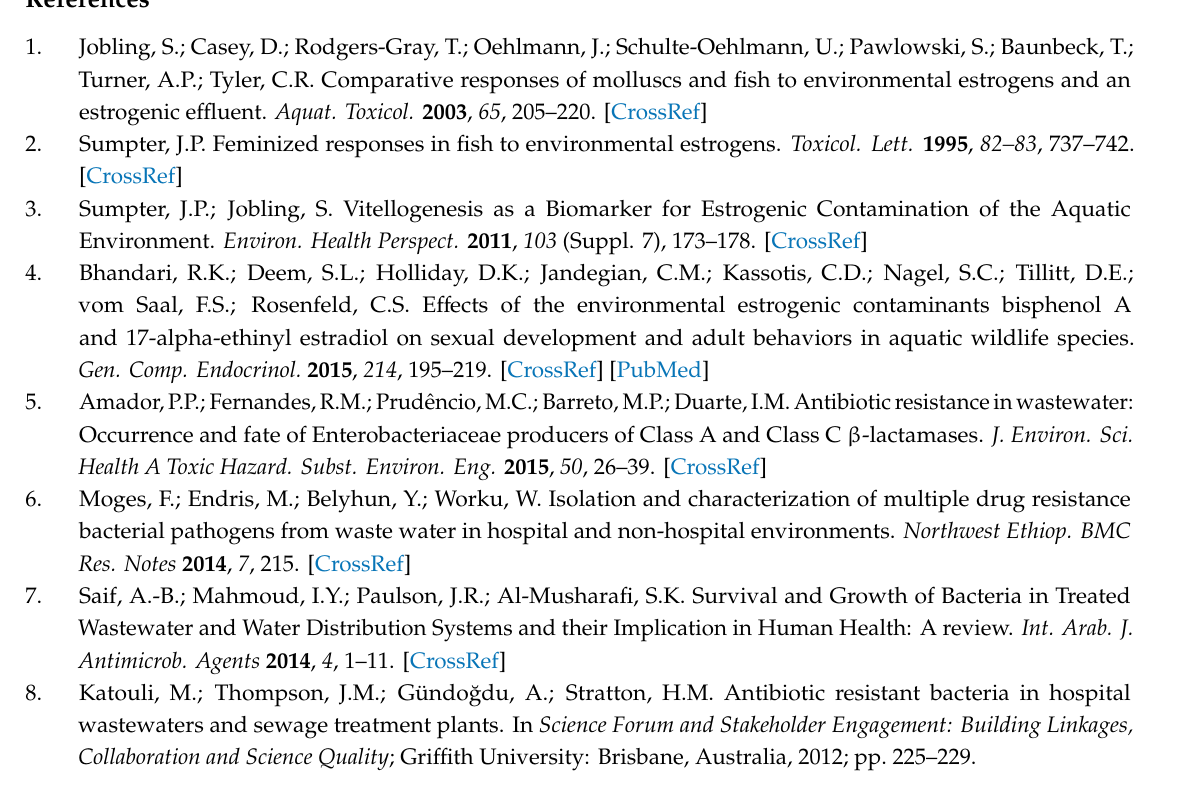
Figure S1: Normalized Kubelka–Munk function F(R ∞ ) with wavelength ( λ ) for the TiO 2 org. sample, Figure S2: Evolution of (F(R ∞ )h ν )2 as a function of the photon energy h ν for the TiO 2 org sample. The intersection of the linear part of the curve with the x-axis gives the band-gap value, Figure S3: Evolution of (F(R ∞ )h ν )1 / 2 as a function of the photon energy h ν for the TiO 2 org sample. The intersection of the linear part of the curve with the x-axis gives the band-gap